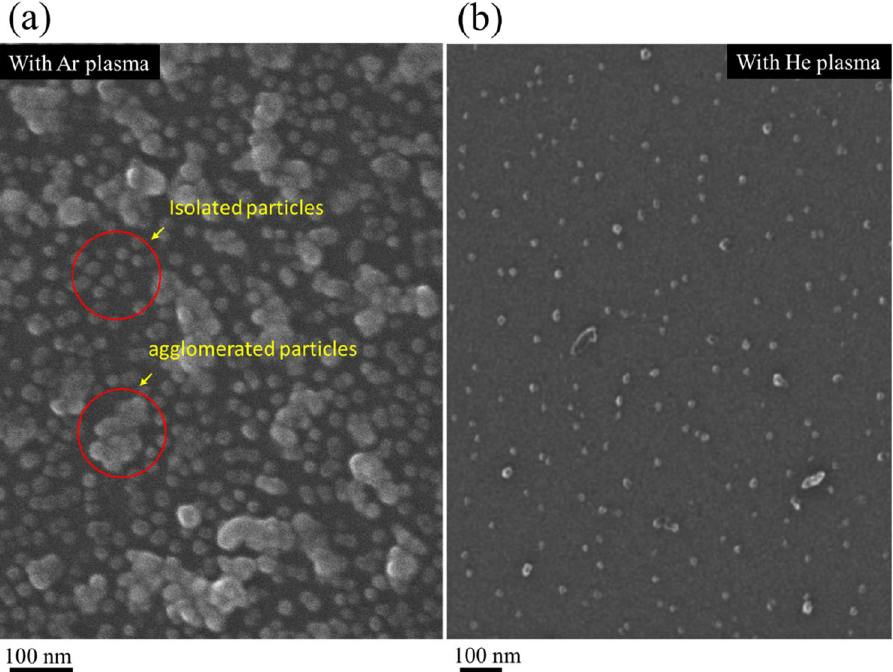
Figure 5. Helium ion microscopy representative images of silver nanoparticle aerosols, collected on Si with discharge jets, excited in argon ( a ), helium ( b ). The red circles drawn in ( a ) is to indicate isolated particles and agglomeration formed by the argon plasma jet. The images were taken with a GFIS field of view of 1 µm and an accelerating voltage of 30 kV with a scan dwell time of 1 µs.